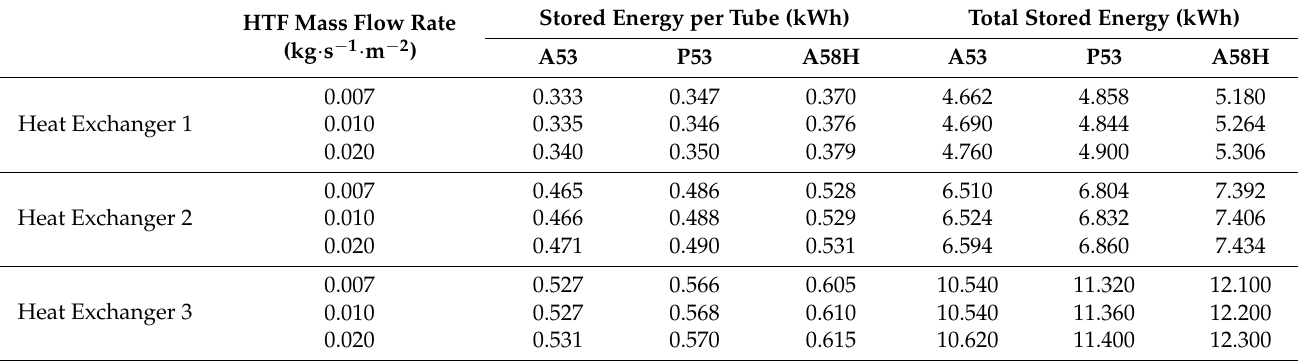
Table A3. Stored energy in A53, P53, and A58H for three different HTF mass flow rates and for each HE